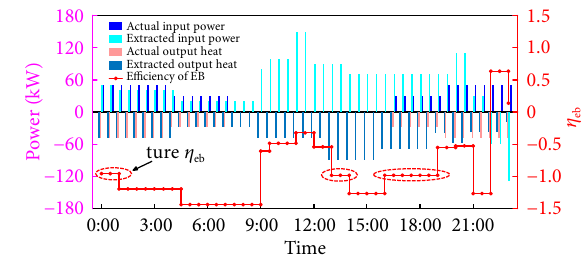
Fig. 4 Different types of energy storage behaviors corresponding to different energy storage characteristics.